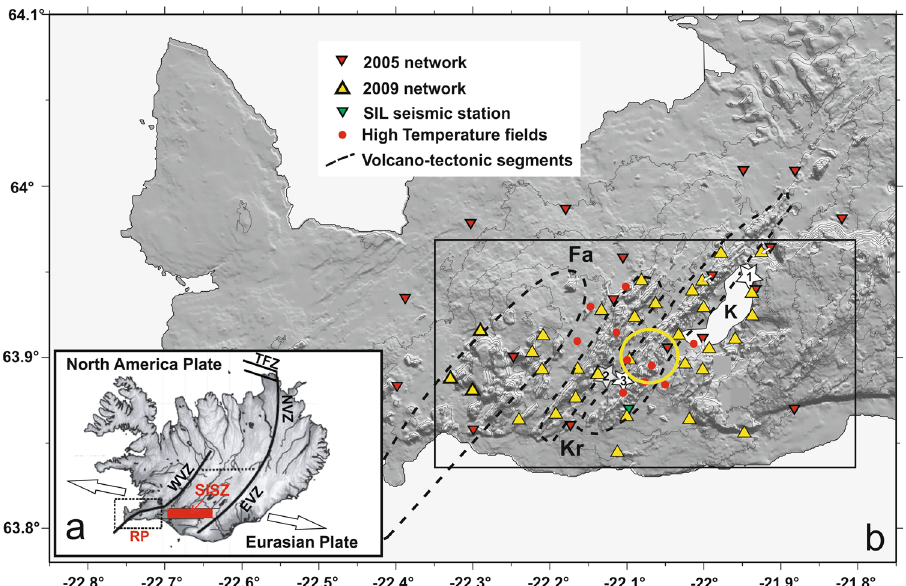
Fig. 1 Distribution of seismic stations during the Hydrorift experiments in the Reykjanes peninsula. a Tectonics of Iceland. Thick lines show main spreading axes. NVZ Northern Volcanic Zone, EVZ Eastern Volcanic Zone, WVZ Western Volcanic Zone, RP Reykjanes Peninsula, TFZ Tjörnes Fracture Zone, SISZ South Iceland Seismic Zone. Dashed rectangle locates the study area. b Map of the Hydrorift seismic networks on the Reykjanes peninsula. En- echelon SW – NE trending volcano-tectonic segments are delimited by dashed lines (Fa Fagradalsfjall, Kr Krýsuvík); K Kleifarvatn. Stars show epicenters of three M ≥ 5 strike-slip events 28 : (1) Kleifarvatn earthquake, June 2000; (2) Núpshlídarháls, June 2000; and (3) Mw 5.0, August 2003. Yellow circle shows the uplifted area measured by geodesy in the 2006 – 2008 period 51 . Digital elevation model was created from open data available from National Land Survey of